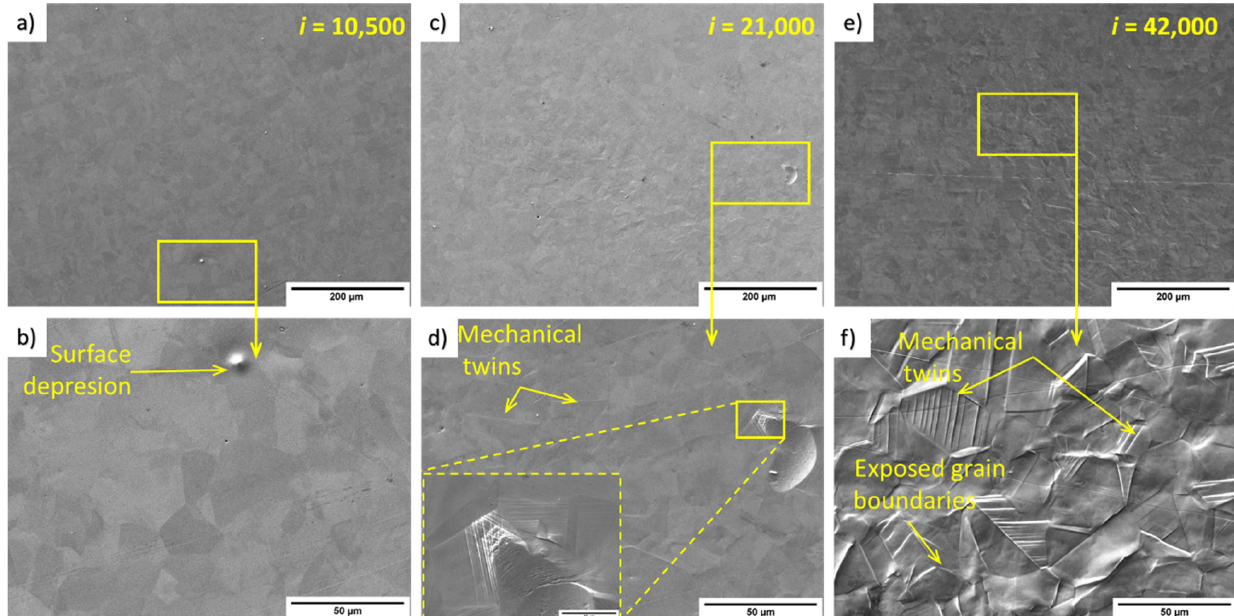
Figure 9. SEM micrographs of the surface of a 316L sample treated by PWJ for different durations, all in SE mode. ( a ) Overview and ( b ) detail of the surface after 10,500 impacts. ( c ) Overview and ( d ) detail of the surface after 21,000 impacts. ( e ) Overview and ( f ) detail of the surface after 42,000 impacts.